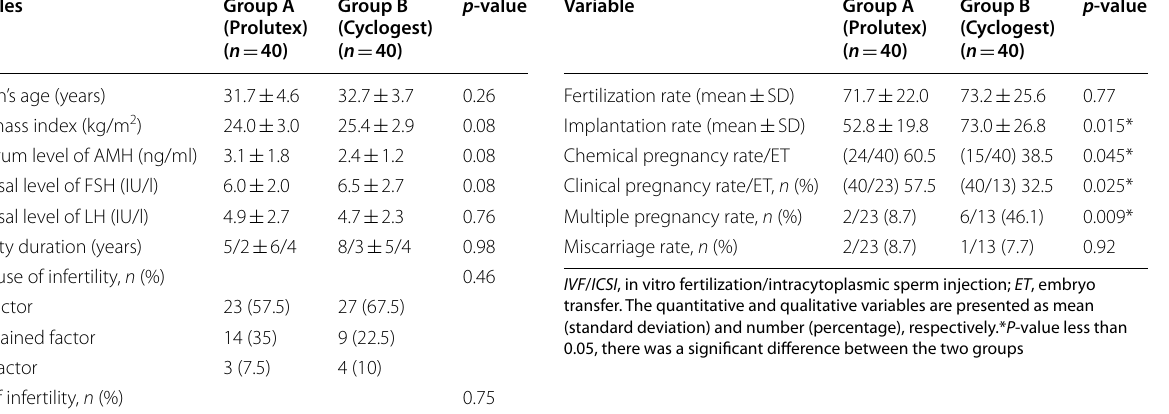
Table 1 Comparison of the patients’ baseline characteristics between two groups